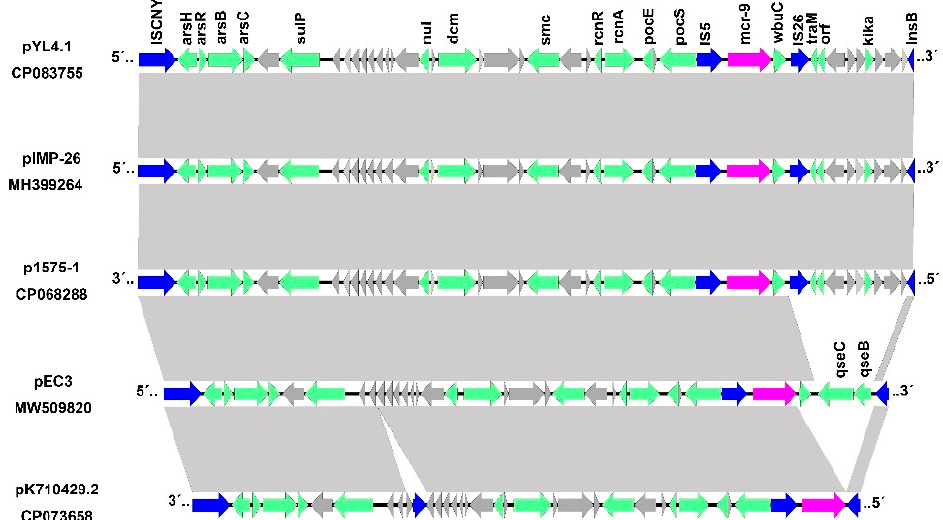
Figure 3. Comparison of the genetic environment of mcr-9 in different plasmids. Magenta arrows indicate resistance genes, blue arrows indicate insertion sequences, green arrows indicate identified ORFs, and gray arrows represent hypothetical genes. Shaded regions denote homologous regions (>95% nucleotide identity).